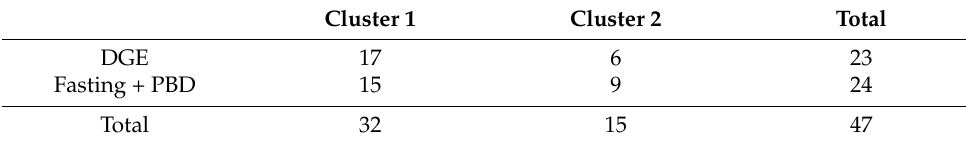
Table 4. Cluster analysis on baseline versus week 6.